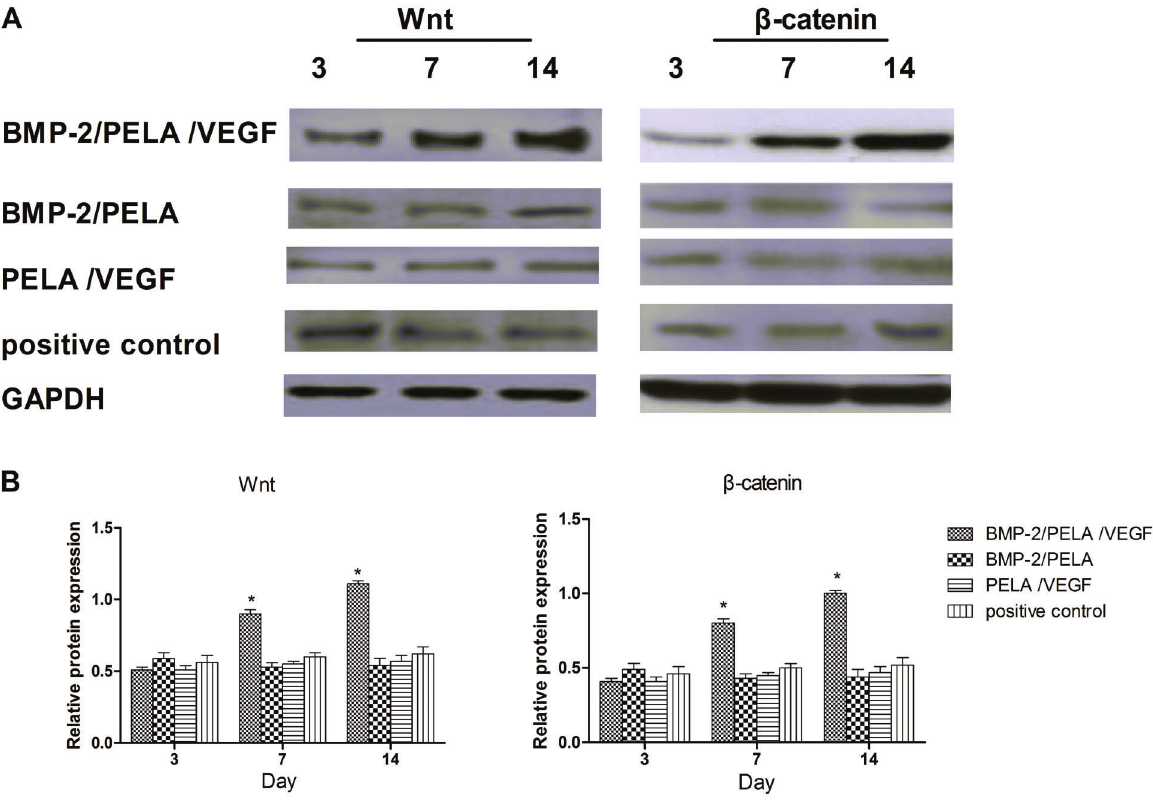
Figure 5. Expression of Wnt and b -catenin proteins in BMP-2/PELA/VEGF and BMP-2/PELA scaffolds, as well as the positive control. A , Western blotting images. B , Quanti fi cation of Wnt and b -catenin expression based on western blotting analysis. Results are reported as means ± SD (n=5). *P o 0.05, compared to the 3-day group (ANOVA). BMP-2: bone morphogenetic protein-2; PELA: polylactide-poly (ethylene glycol)-polylactide; VEGF: vascular endothelial growth